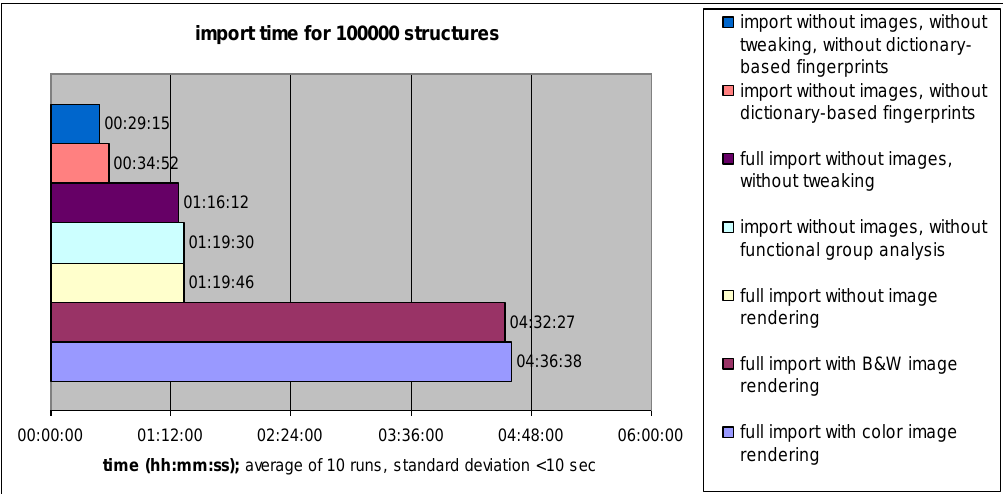
Figure 4. Time required for batch data import with different processing